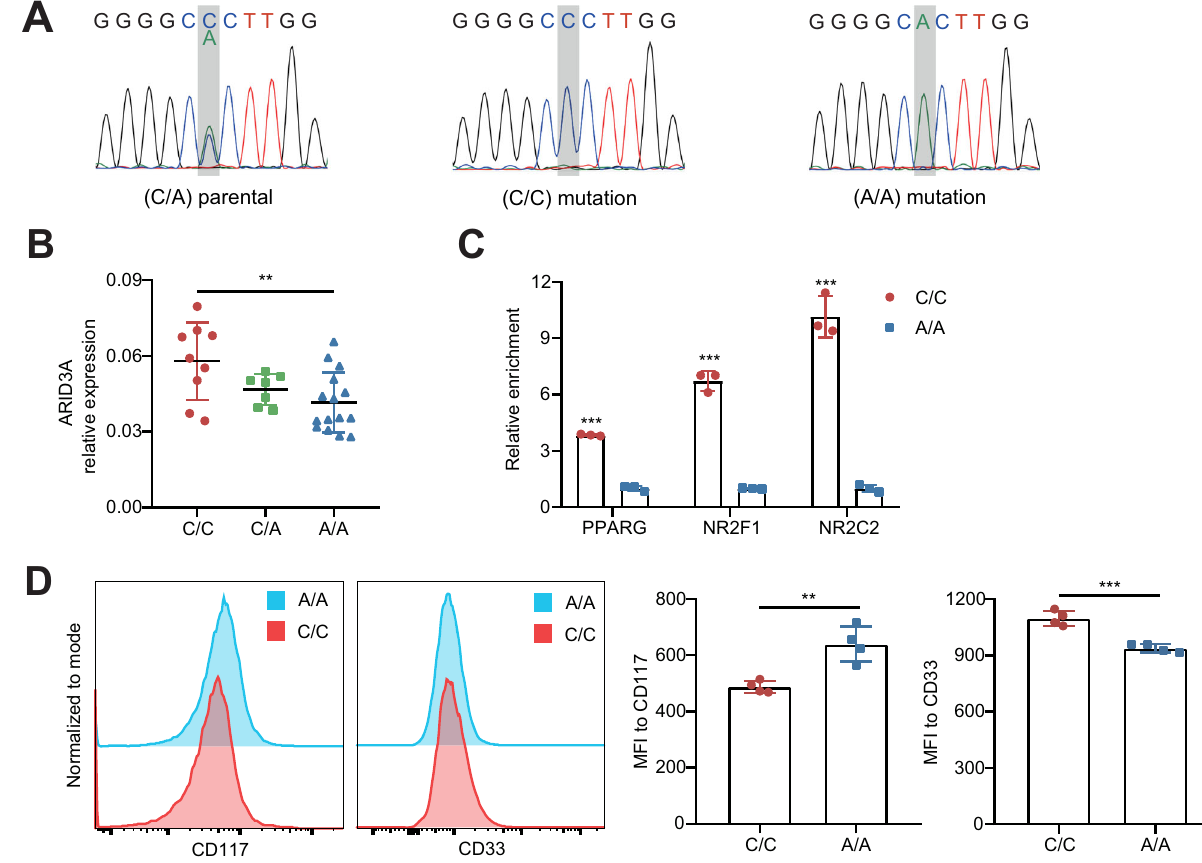
Fig. 5 | Effects of rs2238574 genotypes on ARID3A expression in K562 cells. A Sanger sequencing of CRISPR/Cas9-modi fi ed and parental K562 cells. B Relative expressionof ARID3A inmutatedandparentalK562cells(C/C, n =9;C/A, n =7;A/A, n =15). C ChIP-qPCR results showing different enrichment of PPARG, NR2F1 and NR2C2 atthe rs2238574-containing region between C/C and A/A K562 cells( n =